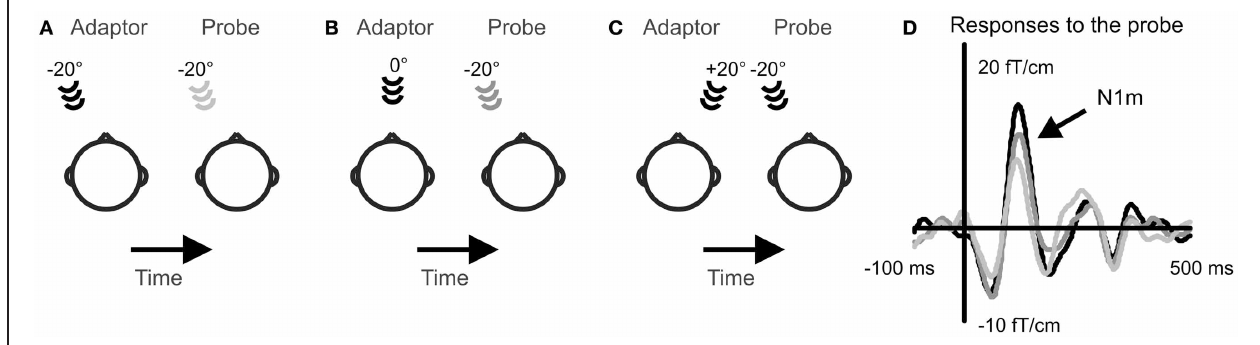
N1m response amplitude increased with growing spatial separation between the probe and the adaptor (D) . Event-related fields averaged over 13 subjects and over the three task conditions are depicted from the gradiometer showing largest N1m amplitudes over the right auditory